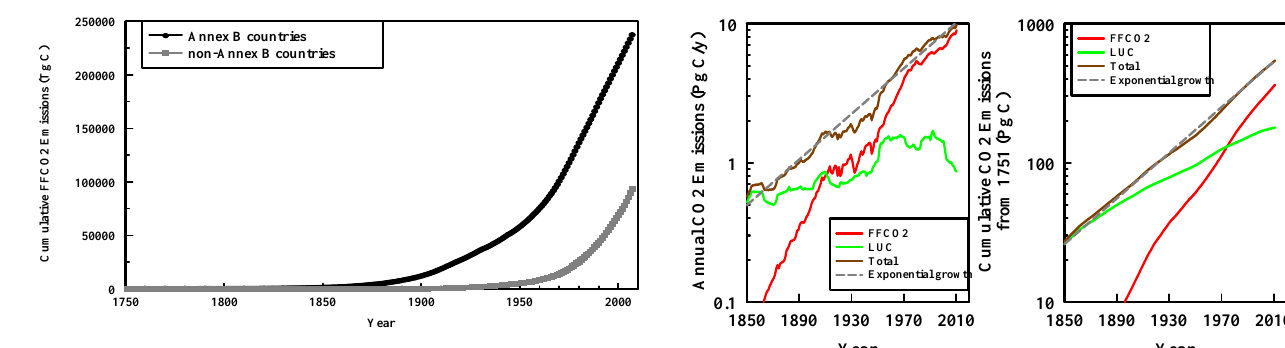
Fig. 3g. Cumulative FFCO2 emissions for years 1751 to 2007, disaggregated by Kyoto Protocol status. Similar to Figure 3c. This figure was created from summing the data in Figure 3e. Data from Boden et al. (2010).